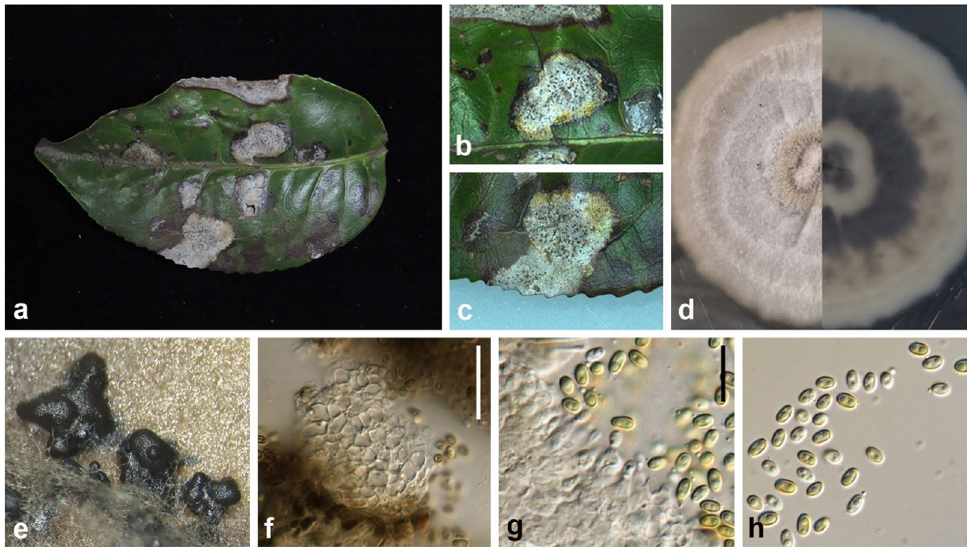
Figure 5. Leucaenicola camelliae (NTUH 18-093-4, holotype ). ( a ) Leaf lesions. ( b , c ) Conidiomata on host surface. ( d ) Cultures on PDA, from above and below. ( e ) Conidiomata on PDA. ( f ) Conidiomatal wall. ( g ) Conidiogenous cells and developing conidia. ( h ) Conidia. Scale bars: ( f ) = 20 μm, ( g , h ) = 10